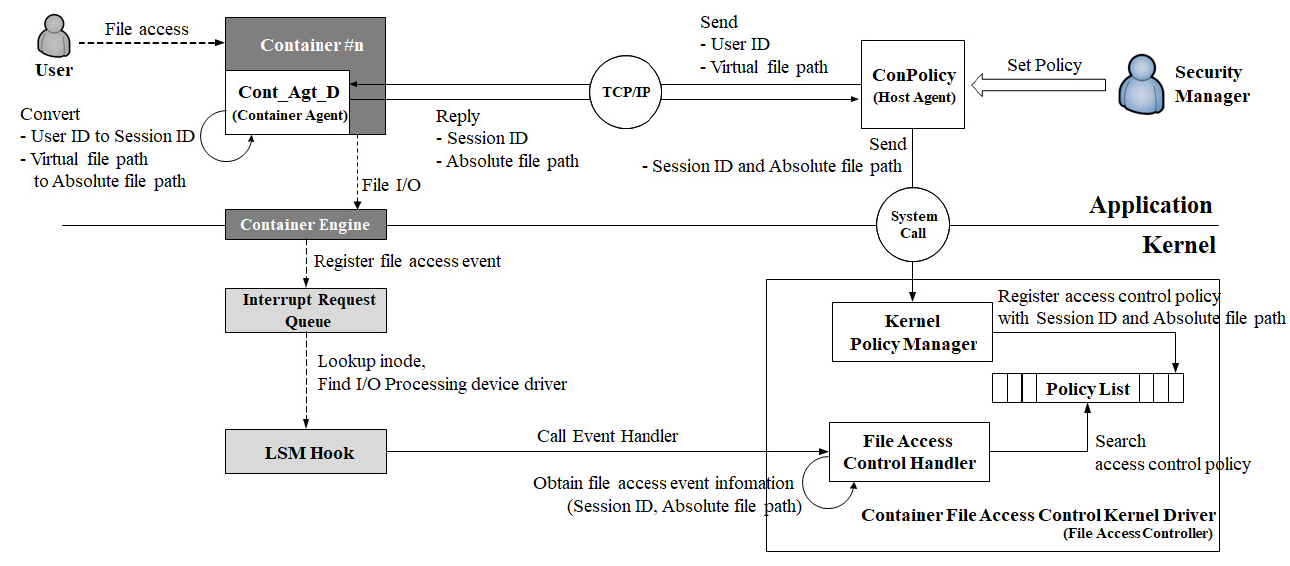
Figure 8. Structure of the container file access control function implemented on Linux.